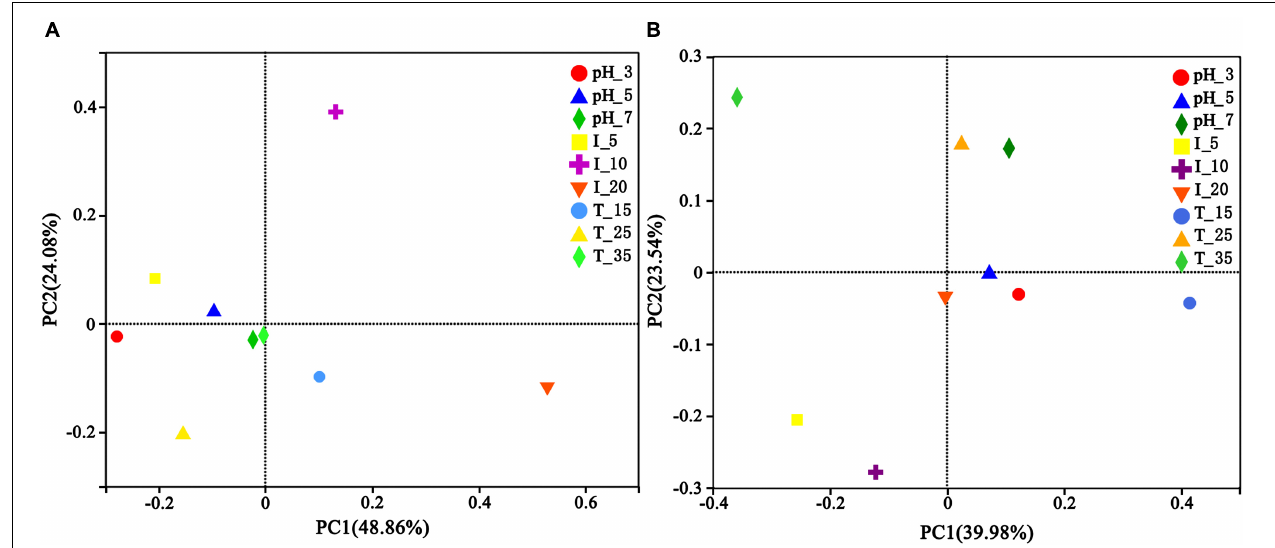
FIGURE 10 | Principle coordinates analysis (PCoA) of uranium tailings after stabilization for (A) 1 day and (B) 15 days under different environmental